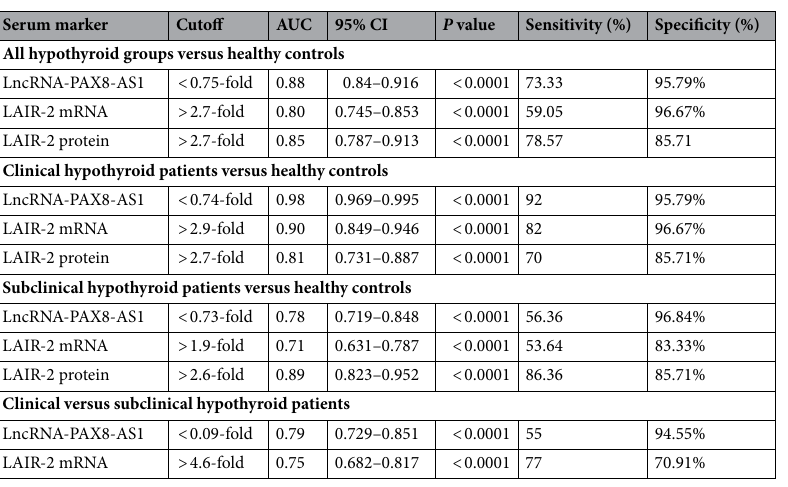
Table 5. Diagnostic accuracy of the studied markers distinguishing candidate groups. AUC area under the curve, CI confidence interval . P < 0.05 means statistical significance.